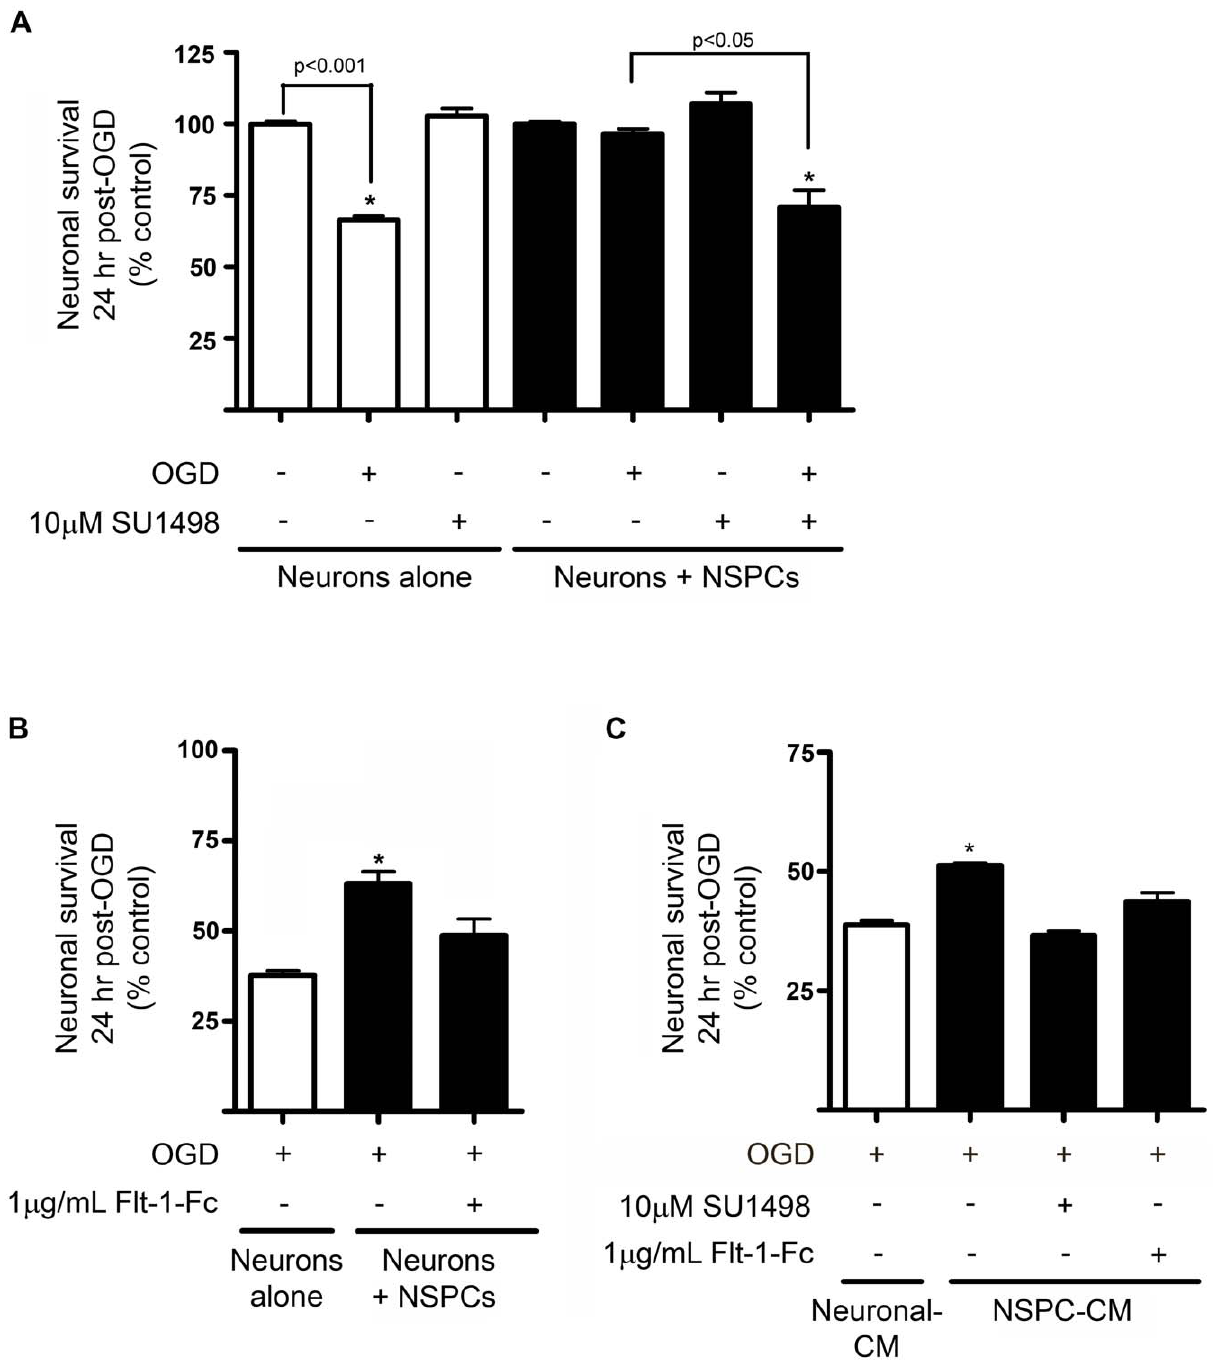
Figure 4. Pharmacological inhibition of VEGF signaling impairs the neuroprotective effects of eNSPCs. ( A,B ) Neuronal viability 24 hrs following exposure to 2 hr OGD vs. control conditions in the presence or absence of NSPCs and the VEGFR kinase inhibitor, SU1498 (A) or the VEGF receptor decoy receptor, Flt-1-Fc (B). ( C ) Neuronal viability in the presence or absence of NSPC-conditioned media and SU1498 or Flt-1Fc. *p , 0.05, n=4 cultures/group.